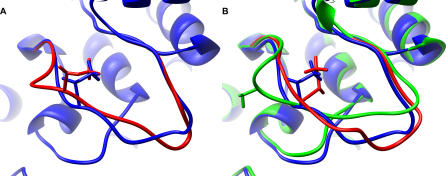
Loop Reconstruction and Prediction in CDK2/Cyclin A(A) Reconstruction: Crystal structure of phosphorylated CDK2/cyclin A (blue) and the predicted loop structure (red). The starting structure for the prediction was the phosphorylated structure, with the only difference being the loop region.(B) Prediction: Crystal structure of phosphorylated CDK2/cyclin A (blue), the crystal structure of the unphosphorylated CDK2/cyclin A (green), and the predicted loop structure upon in silico phosphorylation of the unphosphorylated CDK2/cyclin A structure (red). Figures prepared with Chimera [72].